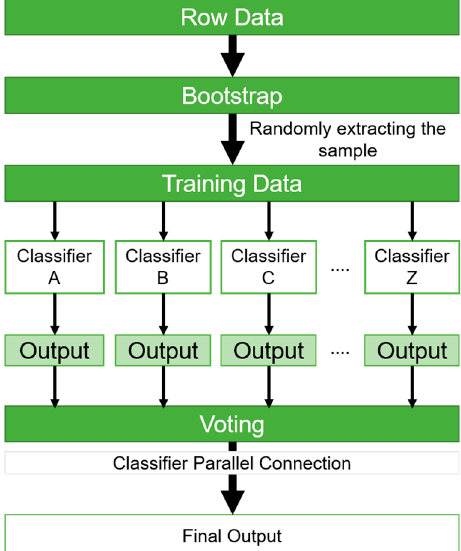
Figure 1. Bagging structure of parallel classifier connection using voting.